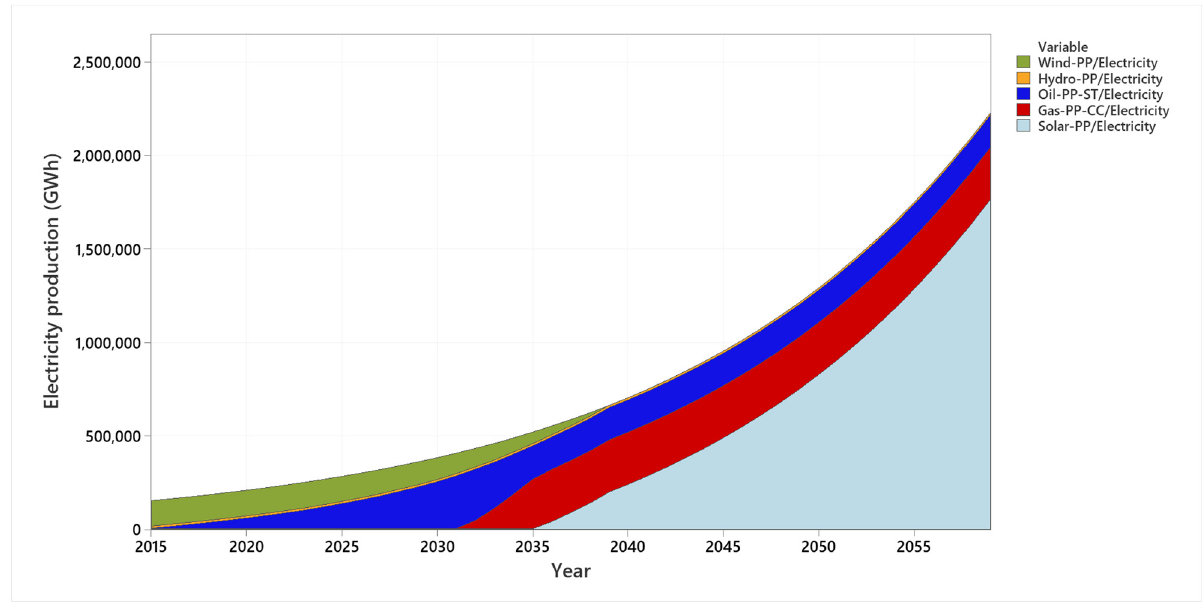
Figure 11. Balance of electricity production of all power plants for fifth scenario, solar case.